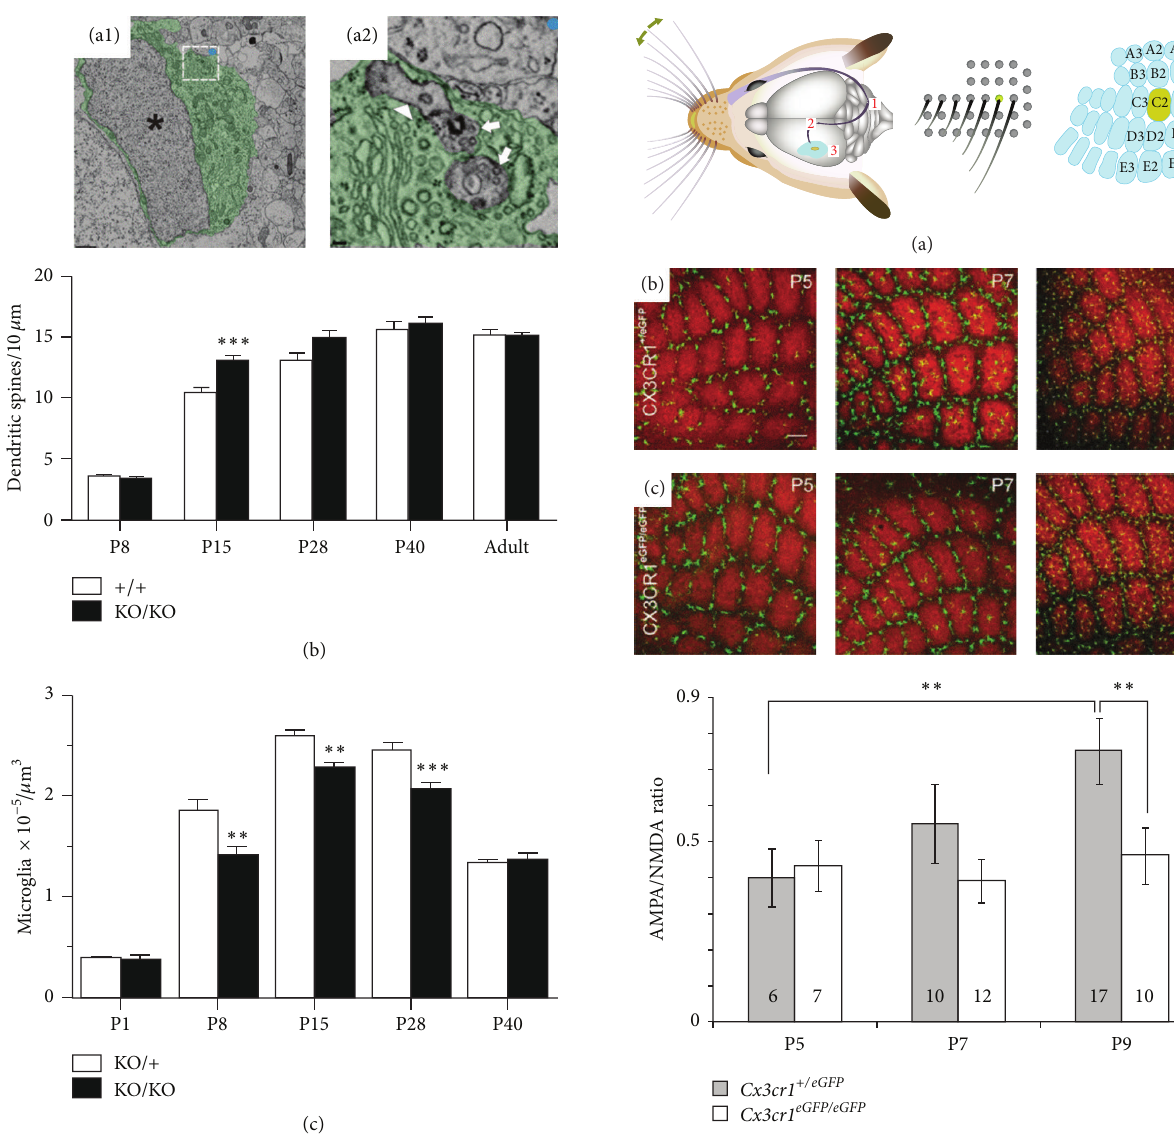
Figure 2: Fractalkine/CX3CR1 signaling modulates synaptic prun- ing by microglia during postnatal development. (a) Microglial cells removepresynapticelementsbysynapticpruningatP5intheretino- geniculate system. (a1) Low magnification electronic microscopy of microglia. Asterisks denote the nucleus and the cytoplasm is pseu- docolored green. Scale bar = 1 𝜇 m. (a2) Magnified regions of (a1) (white box) demonstrating membrane-bound elements engulfed by microglia. Arrows designate elements containing presynaptic machinery (40nm vesicles). The arrowhead designates engulfed material resembling juxtaposed postsynaptic elements. Scale bar = 100nm. Adapted from [53]. (b) A transient increase in dendritic spine density was observed in CX3CR1 deficient (KO/KO) mice when compared with WT (+/+) littermates during the second postnatal week ( ∗∗∗ 𝑝 < 0.0001). This transient increase in dendritic spines number could result of a transient deficit of synaptic pruning. (c) Quantification of microglia nuclei in the CA1 stratum radiatum from the hippocampus revealed a transient decrease in microglia density in CX3CR1 deficient mice at P8, P15, and P28 compared with controllittermates ( ∗∗ 𝑝 < 0.005). Thisdecreaseinmicroglianumber in KO mice suggests a transient delayed microglia recruitment which can explain the transient deficit of synaptic pruning. ((b) and (c)) Adapted from [47].